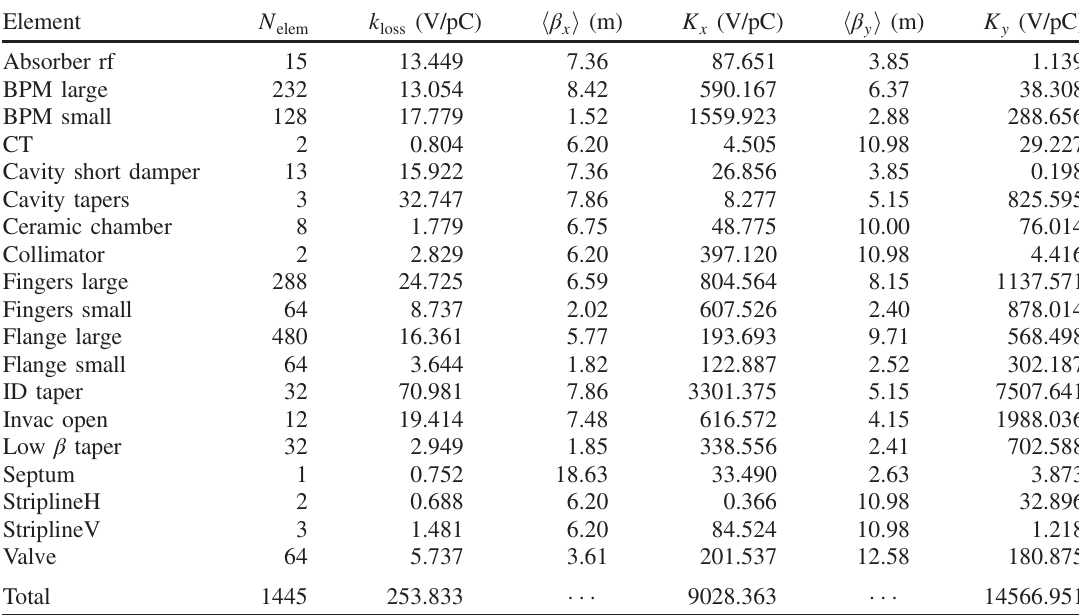
TABLE III. Breakdown of simulated machine elements that comprise the geometric short range wakefield model. Large and small refer to the aperture sizes. The β functions are the average β functions at all of the locations of the element. The loss parameter and kick factors include the number of occurrences and β functions.